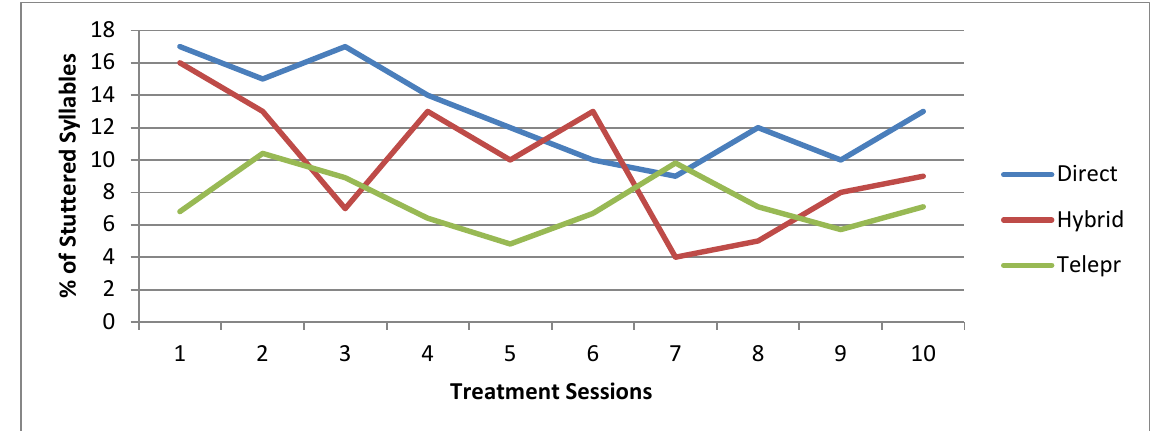
Figure 5. Participant 1: Percentage of stuttered syllables across intervention periods (Telep= Telepractice).